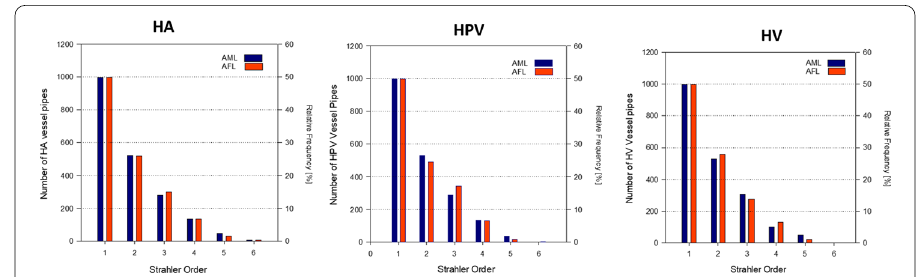
Fig. 6 Distribution of virtual vessels of HA, HPV, and HV vascular trees per Strahler order in